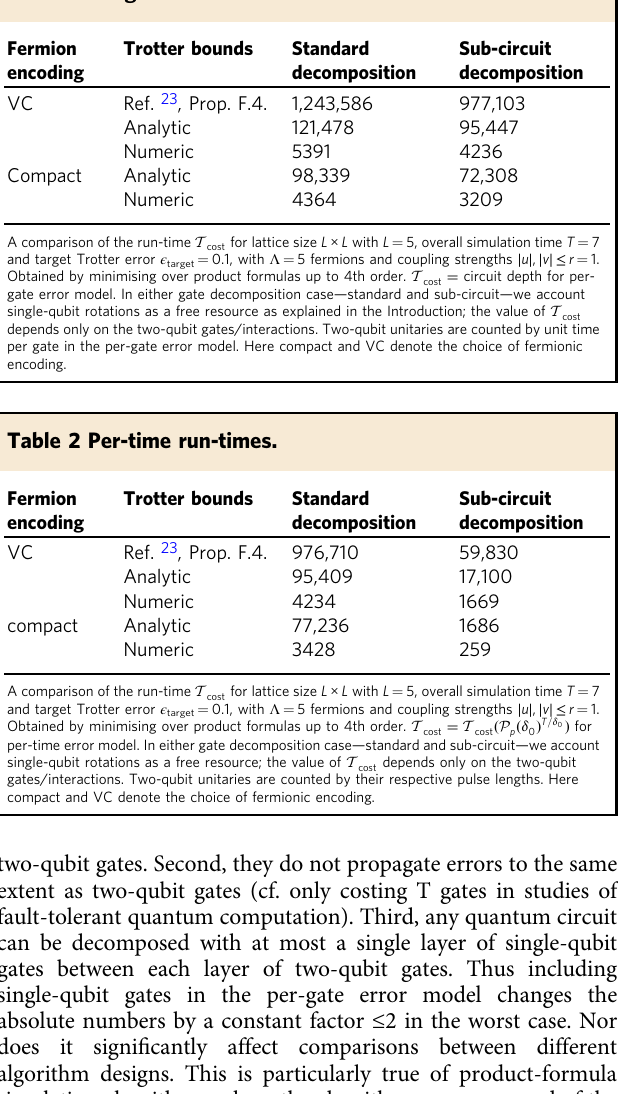
Table 1 Per-gate run-times.